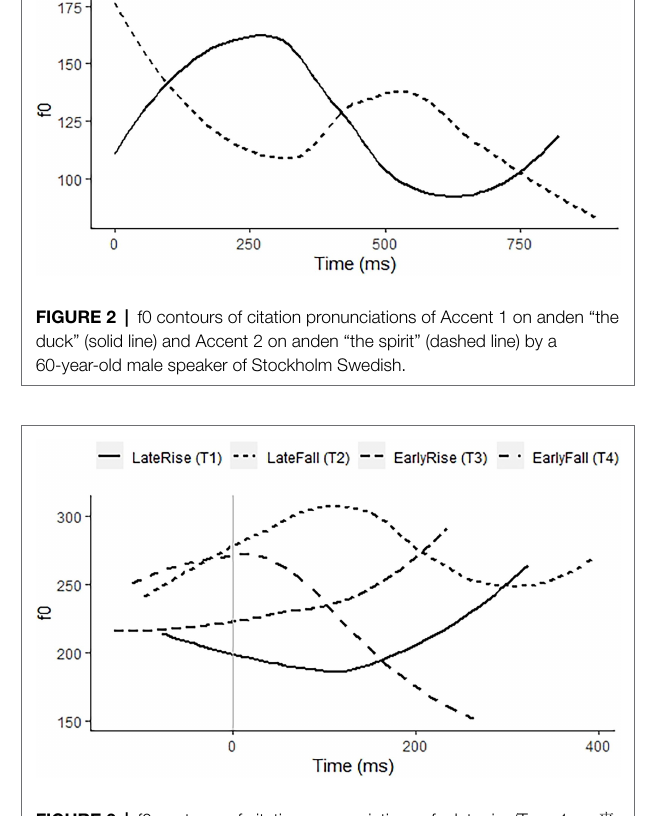
FIGURE 3 | f0 contours of citation pronunciations of a late rise/Tone 1 on 麥 “cereal,” a late fall/Tone 2 on 埋 “bury,” an early rise/Tone 3 on 買 “buy,” and an early fall/Tone 4 on 賣 “sell,” all with the segmental syllable /mae/, recorded by a 22-year-old female speaker of Zhumadian Mandarin.